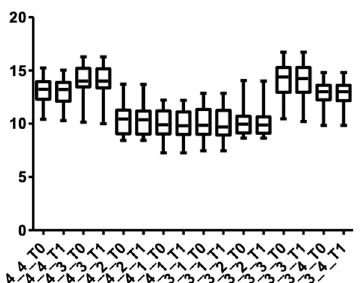
Figure 13. Root length distribution for maxillary teeth at T0 and T1.